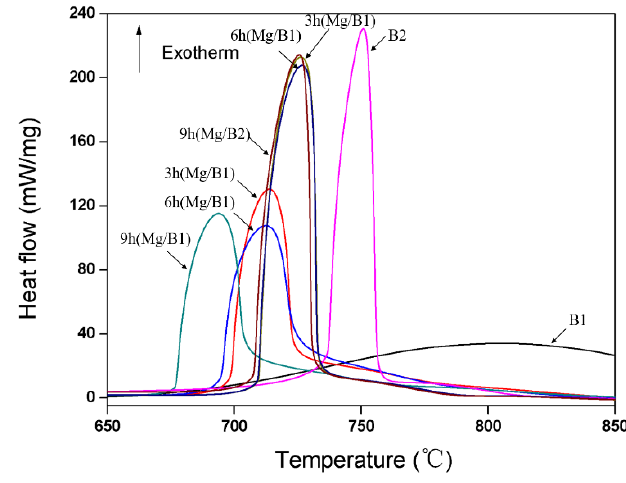
Figure 11. DSC curves of raw B powders and Mg/B composite powders. Table 4. The exothermic peak and released heat.